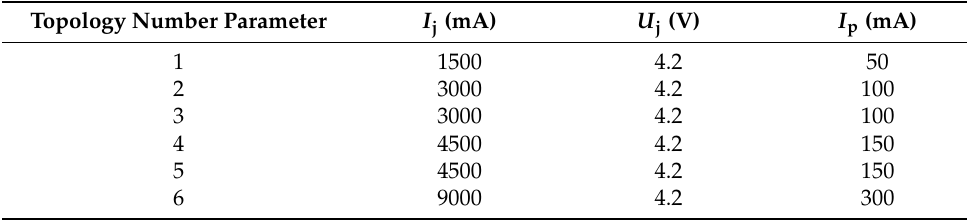
Table 2. Battery system charge and discharge parameters.